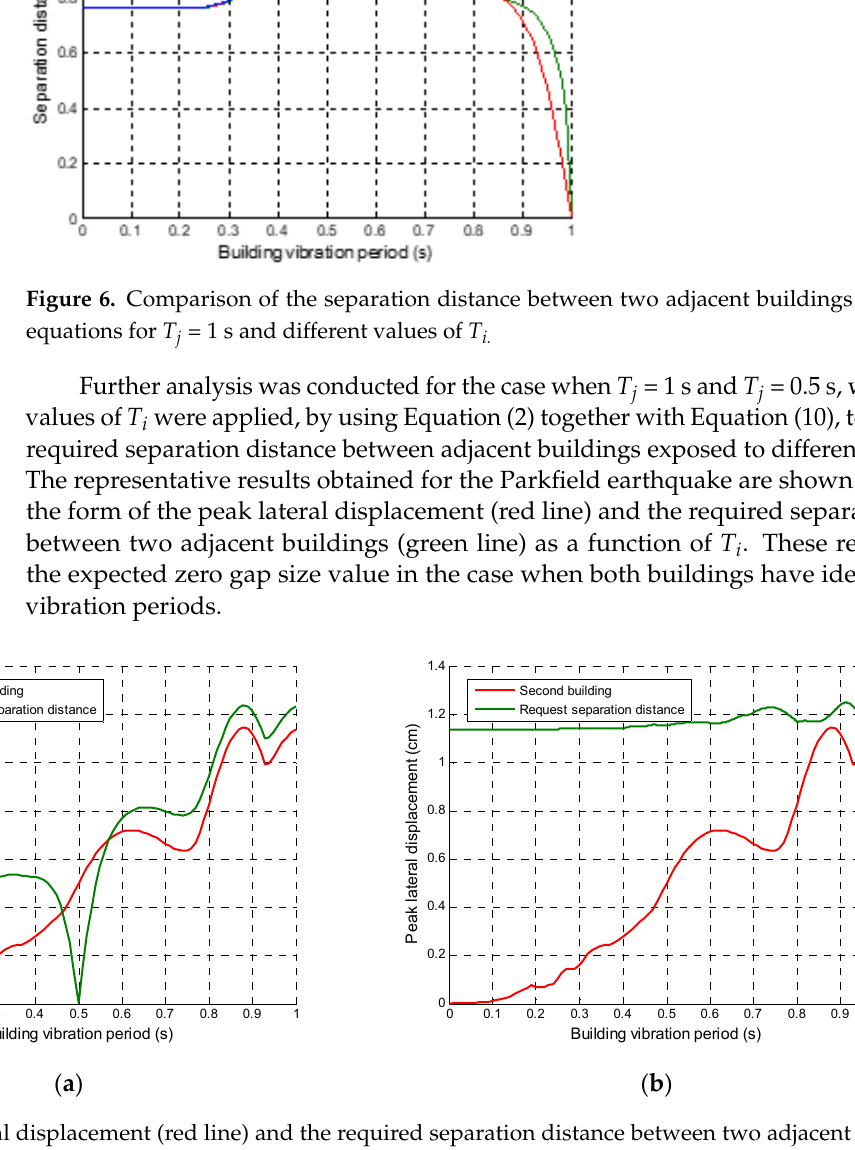
Figure 7. The peak lateral displacement (red line) and the required separation distance between two adjacent buildings (green line) for: ( a ) T j = 0.5 s, ( b ) T j = 1 s and different values of T